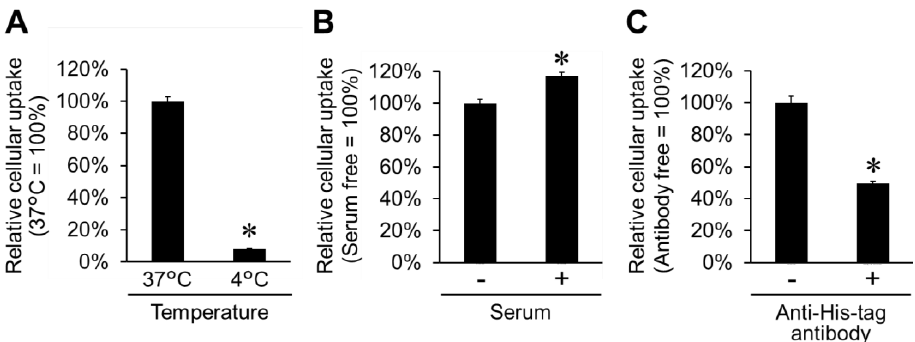
Figure 4. Cellular uptake route of His16-Lyso. Cellular uptake of His16-Lyso (10 µM STR-His16, 5.0 µg/mL lysosomes) in HT1080 cells was determined at 37 °C or 4 °C ( A ), in the presence or absence of 10% serum at 37 °C ( B ), and in the presence or absence of anti-His-tag antibody (1000-fold dilution) at 37 °C ( C ). Cellular uptake was evaluated by the mean fluorescence intensity in a flow cytometric analysis (pH 7.4). Data represent means ± SD. Asterisks indicate significant differences ( p < 0.05, Student’s t -test).